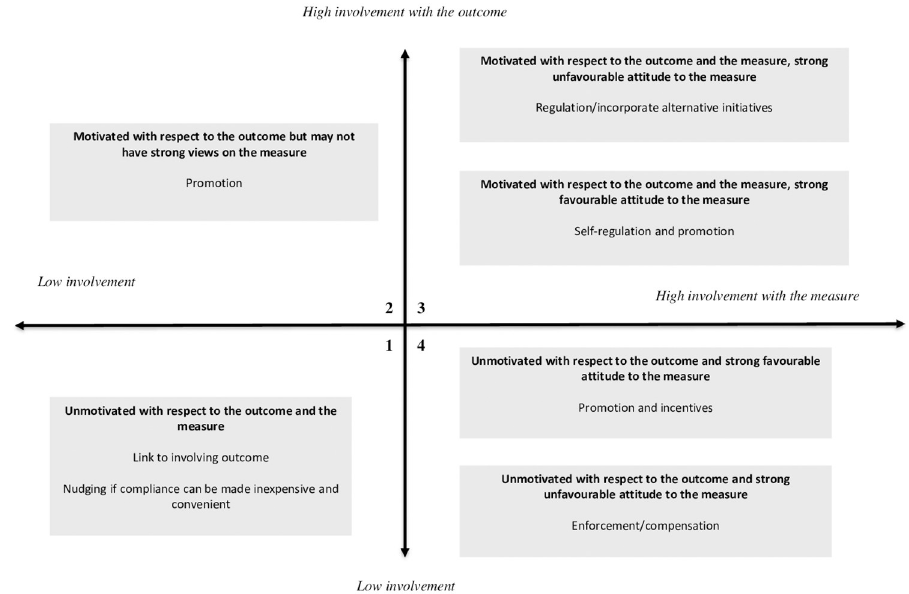
Fig 1. Map and explanation of quadrants in the I 3 response